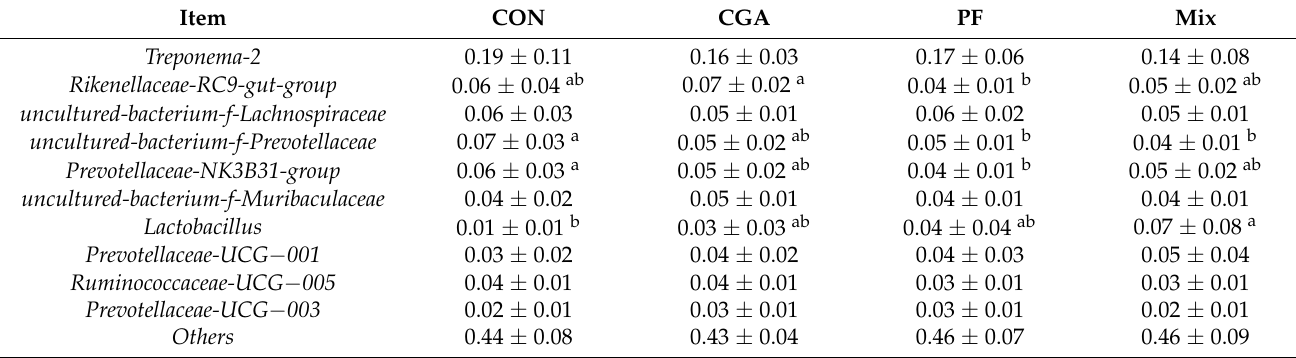
Table 4. Annotation and taxonomic analysis of rectal species in finishing pigs (genus